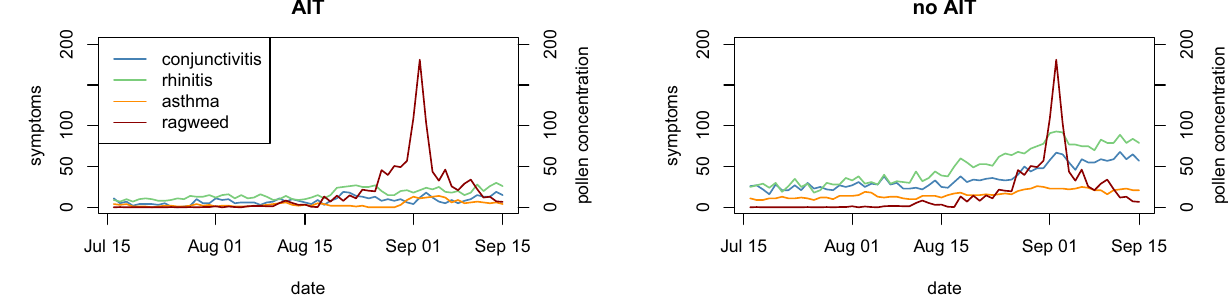
Figure 2. Time series of observed total number of symptoms, for the three categories, in the two groups of patients: AIT treated (left) and no AIT (right), and ragweed mean daily pollen concentrations (secondary Y-axis). Concentrations are provided as daily mean values and are expressed in grains per cubic meter of air (pollen grains/m 3